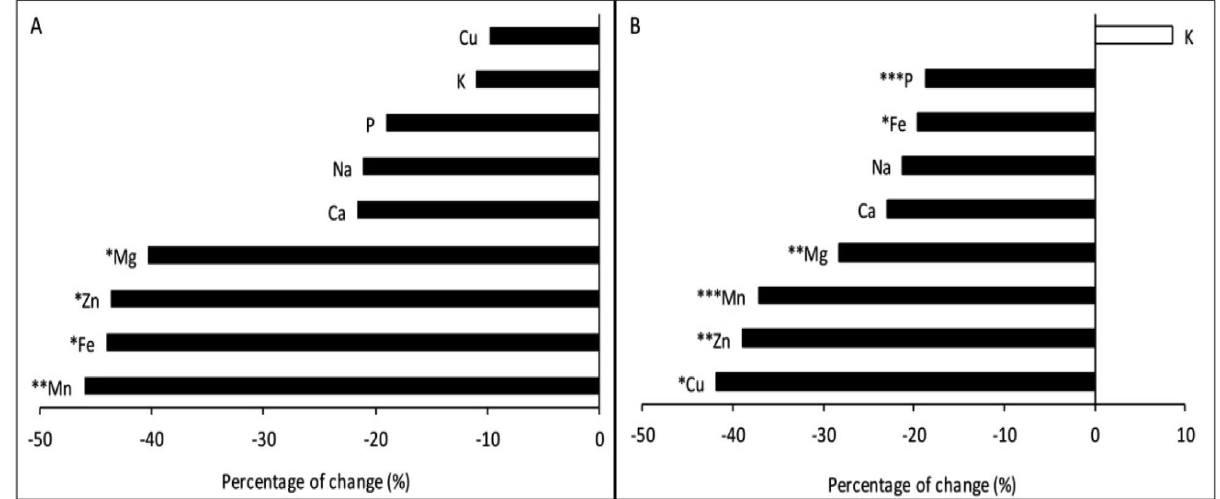
Figure 8. Change in grain minerals concentration relative to [1850–1955] period of global ( A ) and Broadbalk experiment ( B ) samples. Data are means ± standard errors (n = 3–14). Statistically significant effects are indicated with *** for p < 0.001, ** for p < 0.01 and * for p < 0.05 (Fisher’s